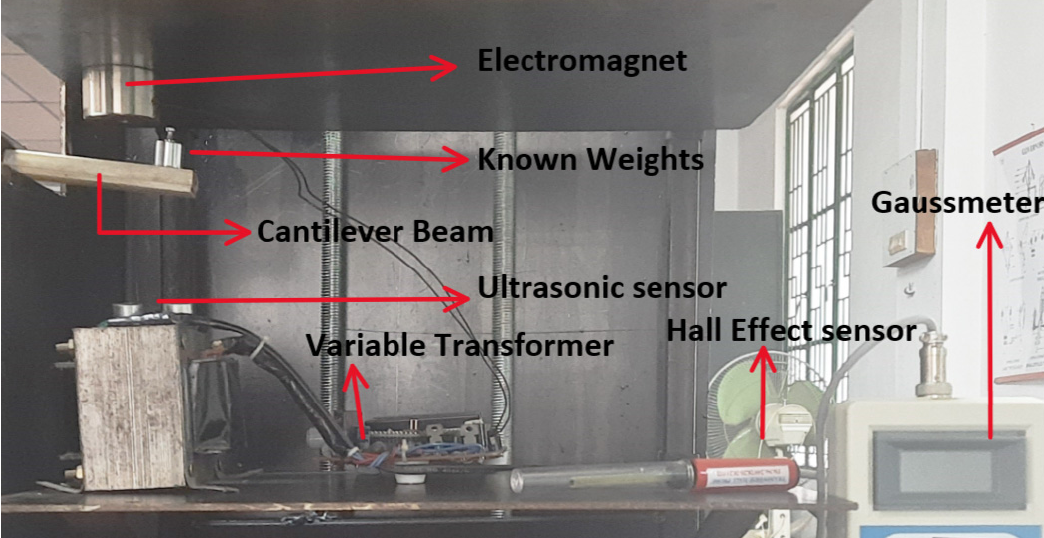
Figure 6. Experimental setup for load–displacement measurement.